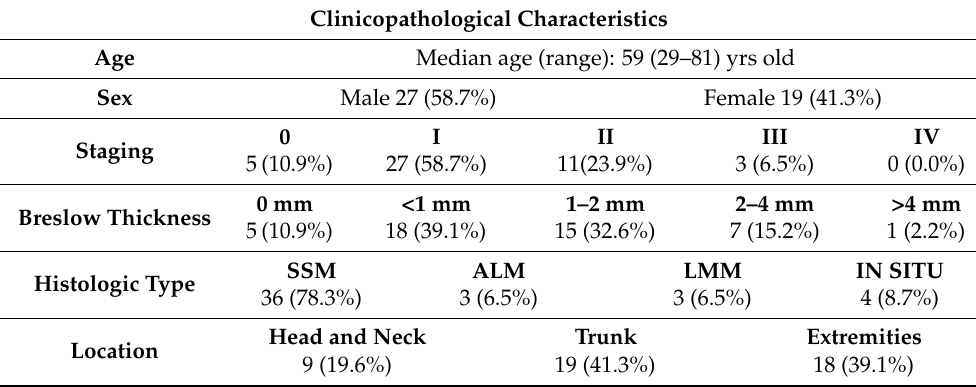
Table 1. Basic clinicopathological characteristics of the 46 samples (45 patients); Histologic Type: SSM: Su- perficial Spreading Melanoma, ALM: Acral Lentiginous Melanoma, LMM: Lentigo Maligna Melanoma.